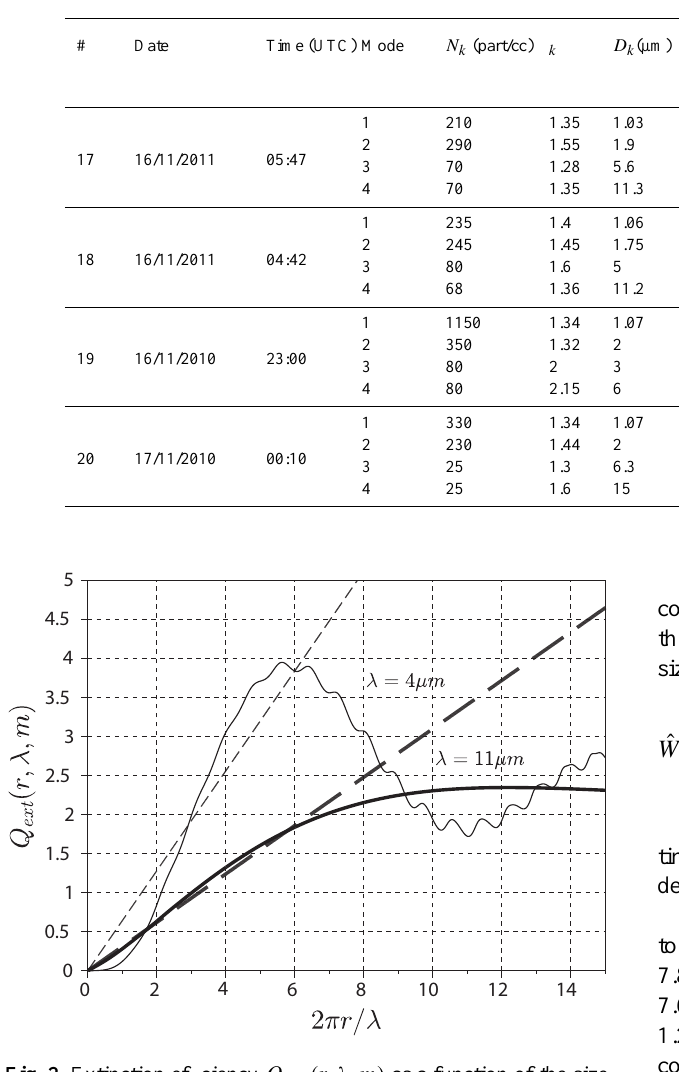
Fig. 2. The maximum radius r m is of the order of the wave- length λ